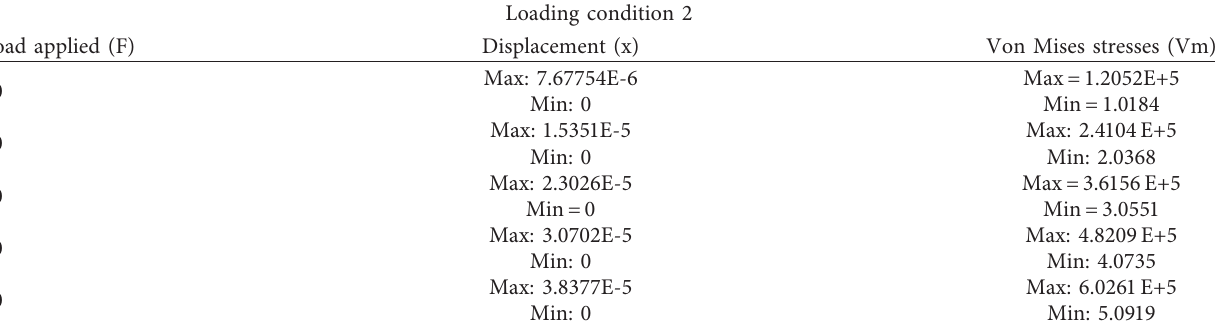
Table 3: Mechanical parameter combination for loading condition 2.